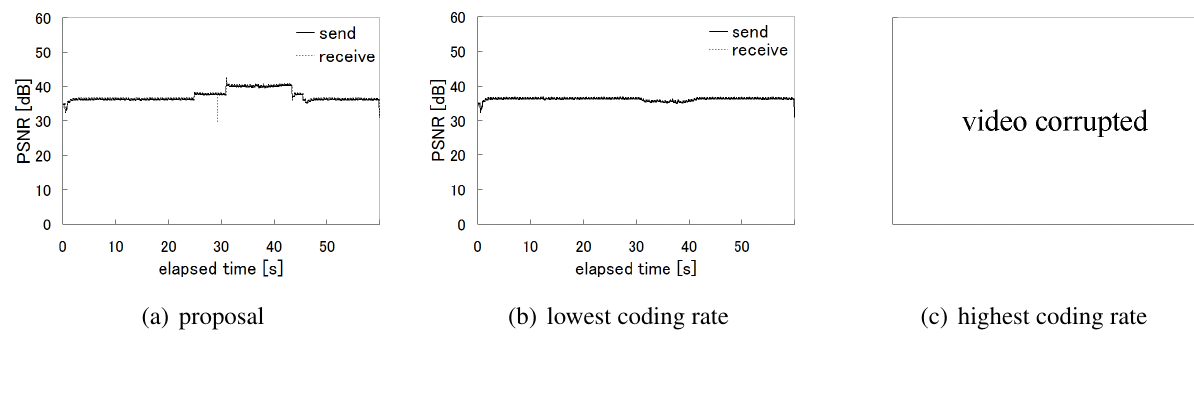
Figure 19 . PSNR of sent and received video data (Node C).